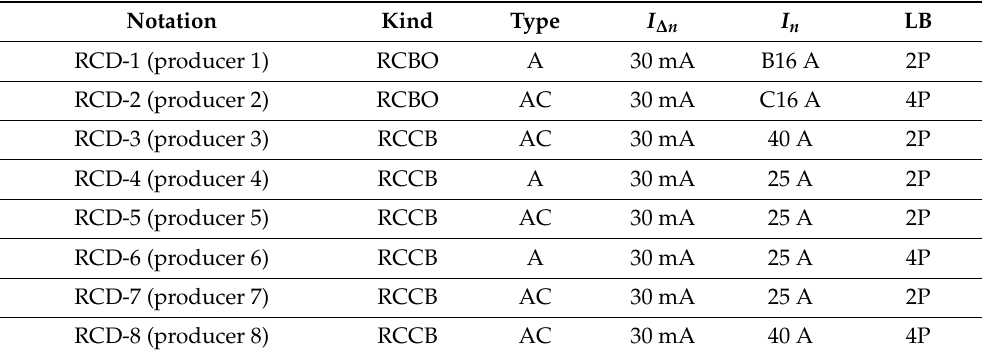
Table 2. List of technical parameters of RCDs subjected to laboratory tests.